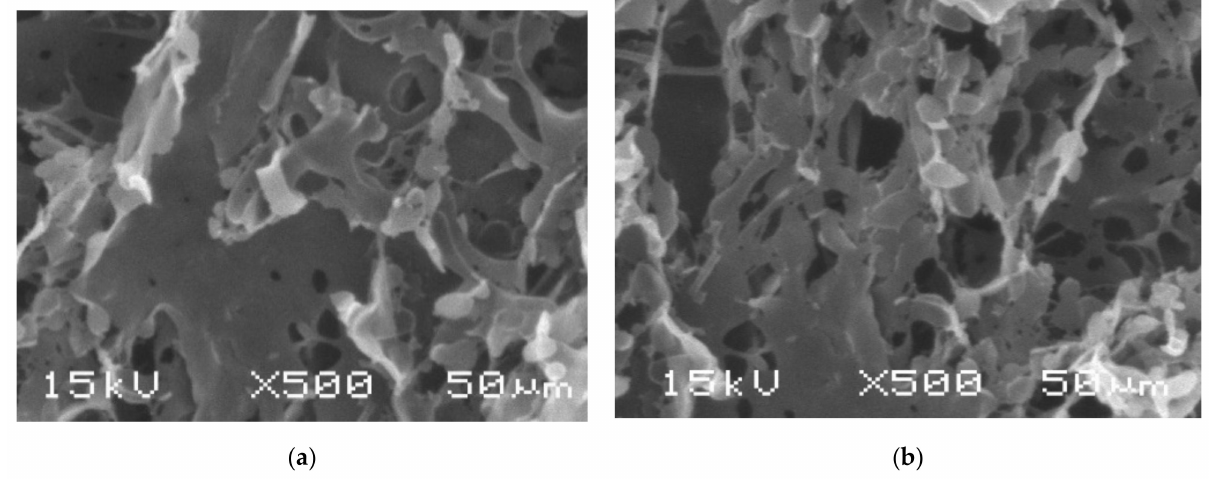
Figure 5. SEM micrographs of lyophilized alkylated ( a ) and native ( b ) pectin hydrogels (Bar: 50 µ